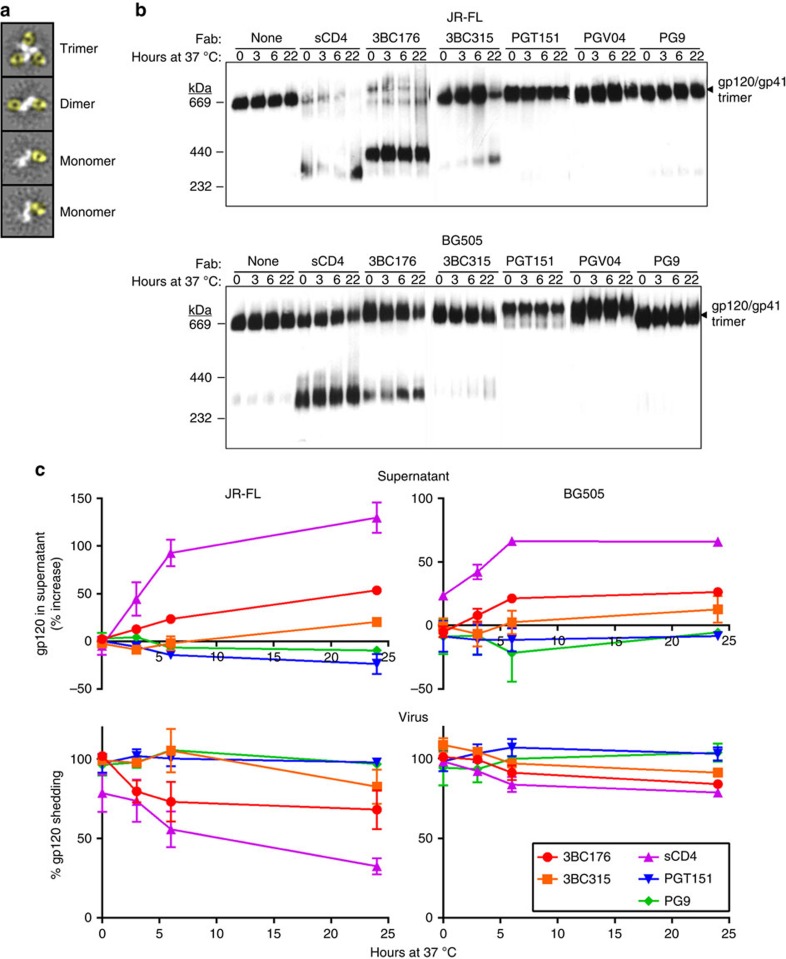
3BC176 and 3BC315 accelerate viral spike decay.(a) Representative 2D class averages seen for dissociated dimers and monomers. Compared with the trimeric Env portion of the protein complex in the top-most class average shown, the dimers and monomers have smaller mass indicating trimer dissociation. Fabs have been coloured in yellow for clarity. The white density corresponding to the SOSIP trimer becomes smaller as the trimer dissociates. Class averages here are generated using the 18-h time point from the JR-FL SOSIP.664: 3BC176 Fab complex. (b) JR-FL and BG505 virions were pre-incubated at 37 °C alone or with 20 μg ml−1 sCD4, 3BC176, 3BC315, PGT151, PGV04 or PG9 Fabs for various time points. Env was then solubilized by 1% DDM, separated using BN-PAGE, and visualized by western blot. (c) JR-FL and BG505 virions were incubated at 37 °C alone or with 20 μg ml−1 sCD4, 3BC176, 3BC315, PGT151 or PG9 Fabs for noted time points. Virions were then pelleted and gp120 shed into the cell culture supernatant (upper panels) or associated with virus (lower panels) was detected using ELISA. The % of increase in gp120 (upper panels) and the % of gp120 remaining with the virus (lower panels) are relative to the untreated control. The scales are not the same in all figures. In both measurements, gp120 shedding is observed when the virus is treated with sCD4 (control), 3BC176 or 3BC315, but not when treated with PG9 or PGT151. Error bars indicate s.d.